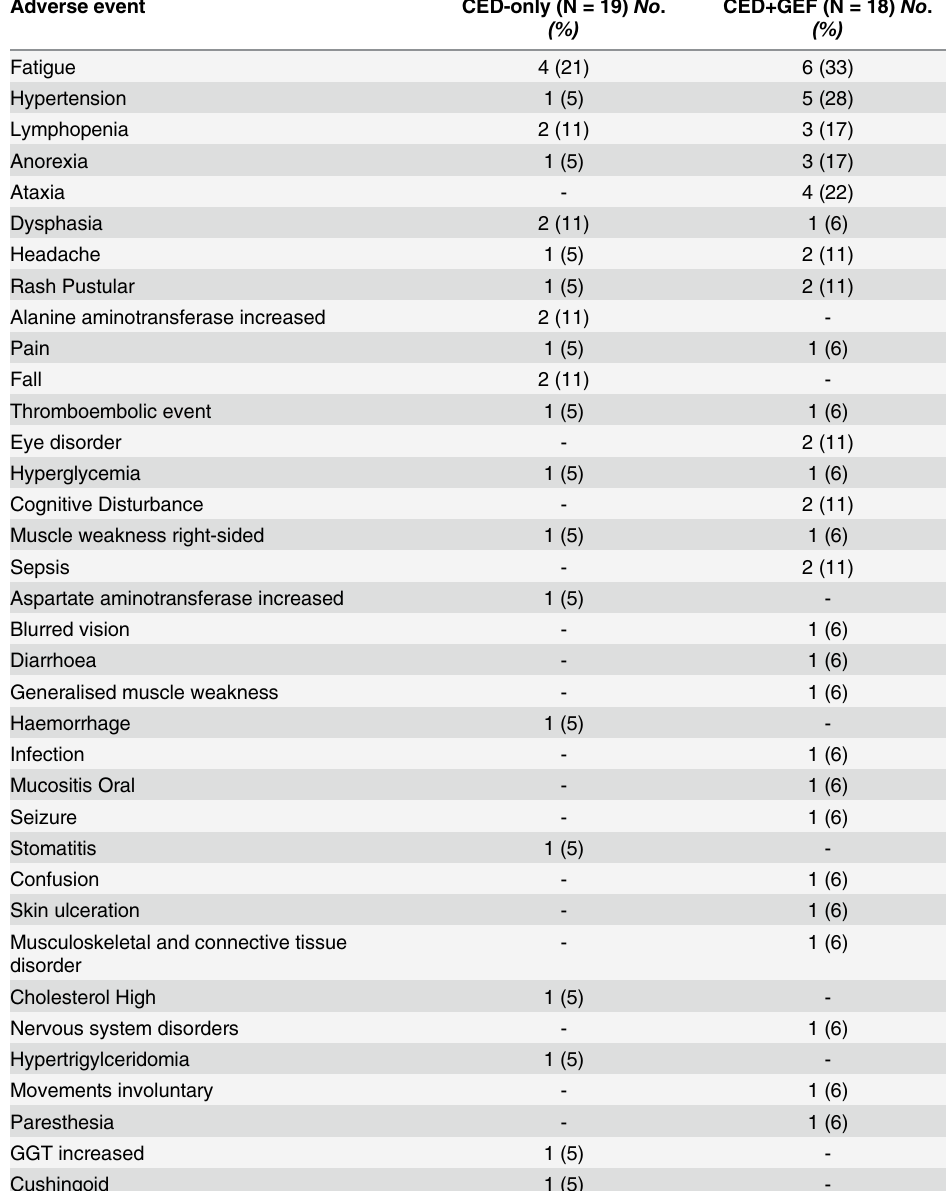
Table 4. Grade 3 & 4 toxicities in the safety population (CTCAE version